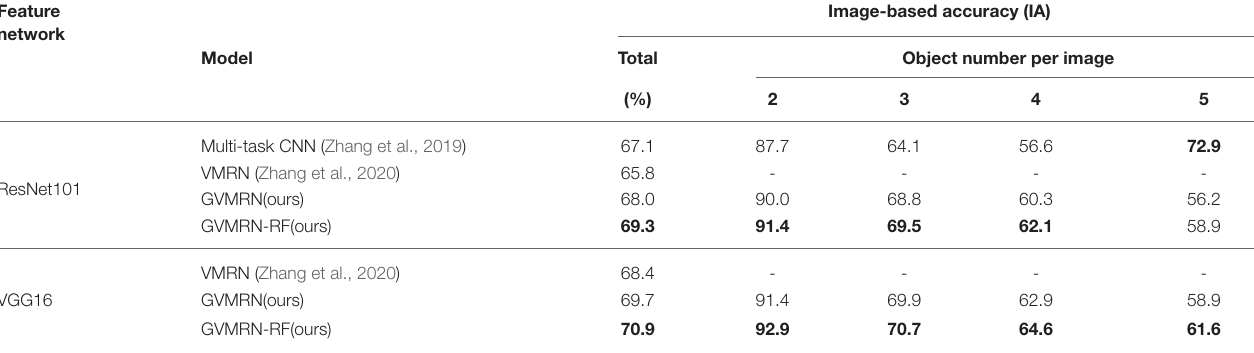
TABLE 2 | Reasoning results of different numbers of objects.